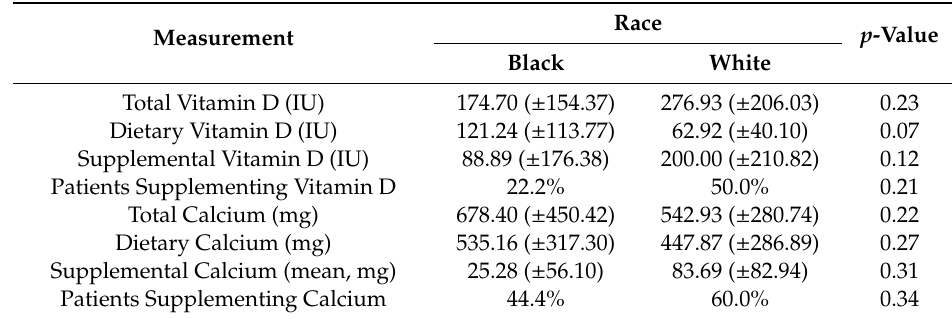
Table 3. Nutrient levels of vitamin D and calcium based on dietary